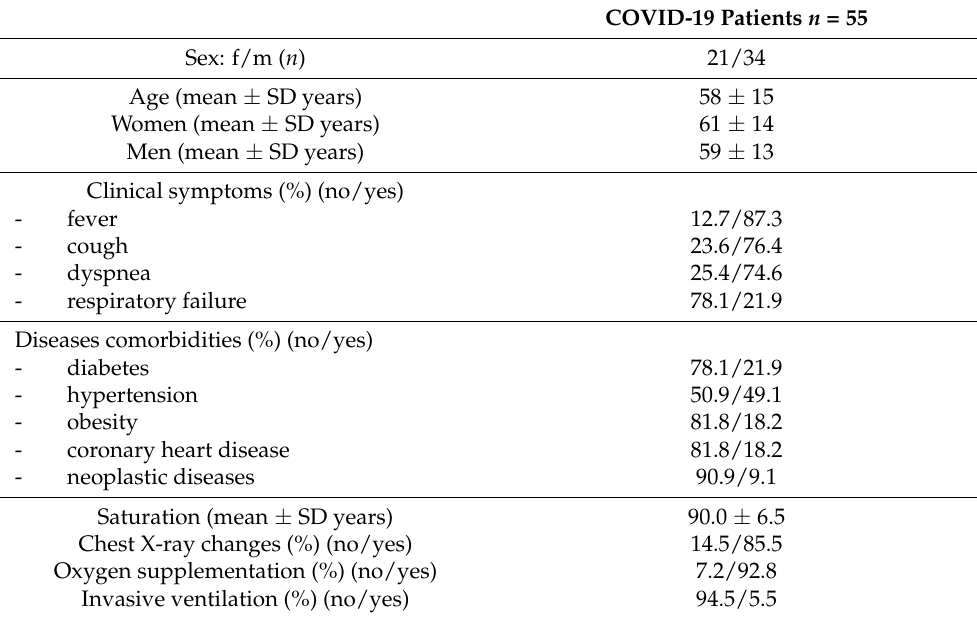
Table 1. Demographic and laboratory data of COVID-19